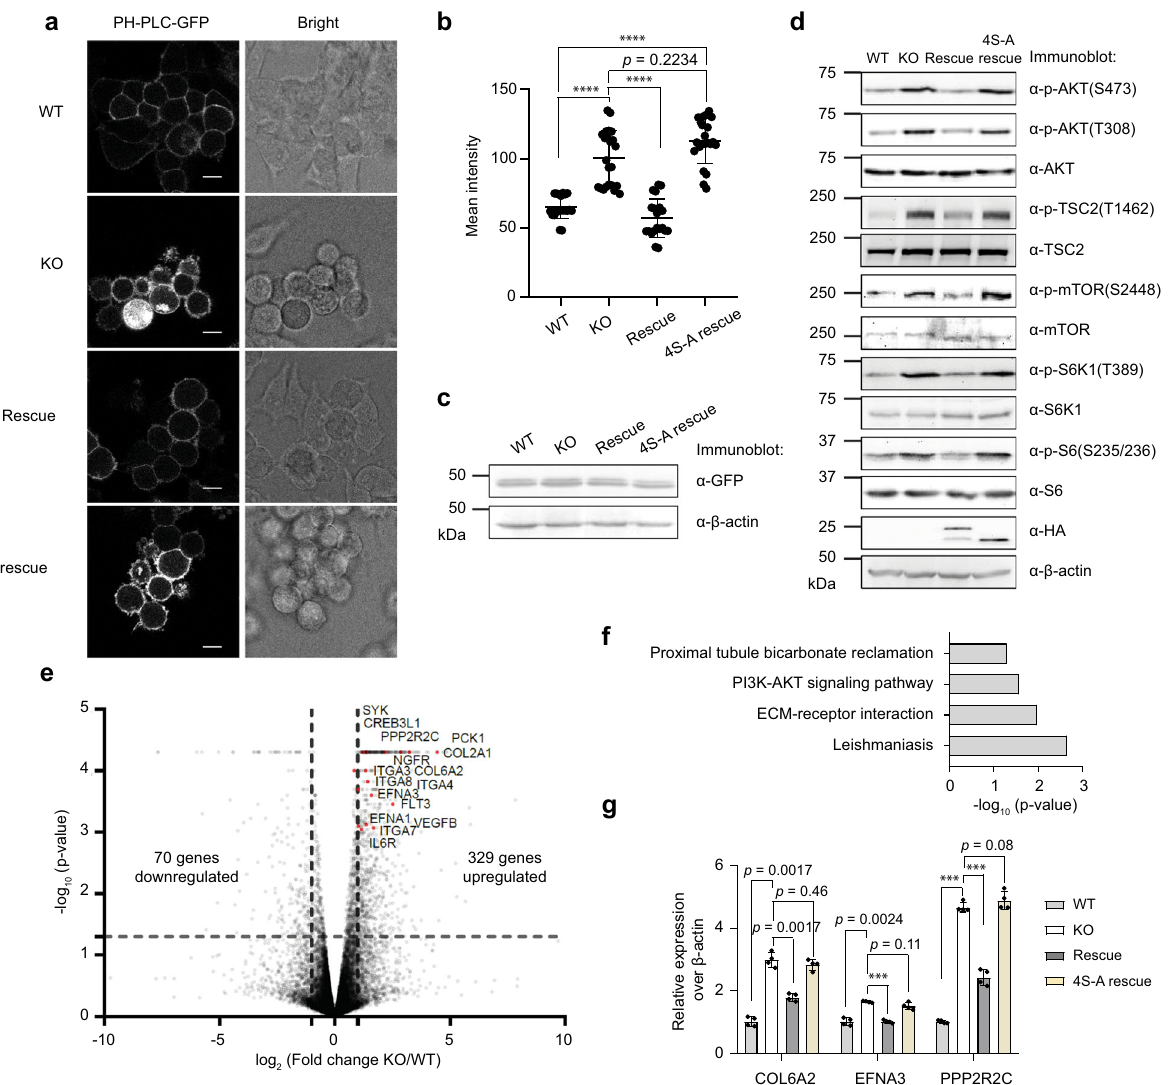
Fig. 5 Phosphorylated alt-RPL36 regulates the PI3K – AKT-mTOR signaling pathway. a Confocal live-cell imaging of wild-type (WT), alt-RPL36 knockout (KO), rescue with wild-type alt-RPL36 (Rescue) or rescue with nonphosphorylatable 4S-A mutant alt-RPL36 (4S-A rescue) HEK 293T cells stably expressing PH-PLC-GFP. Scale bar, 10 µ m. Data are representative of three biological replicates. b Quantitation of the PH-PLC-GFP signals in the four cell lines described above. At least 20 fi elds of view were analyzed, totaling >400 cells for each measurement. Data represent mean values ± s.e.m., and signi fi cance was evaluated with two-tailed t -test. **** p < 0.0001. Source data are provided as a Source data fi le. c Western blot of the four cell lines with antibodies indicated on the right for comparison of PH-PLC-GFP expression. Data are representative of three biological replicates. d Western blot analysis of the wild-type (WT), alt-RPL36 knockout (KO), rescue with wild-type alt-RPL36-FLAG-HA (Rescue) or rescue with 4S-A mutated alt-RPL36-FLAG-HA (4S-A rescue) HEK 293T cells with antibodies indicated on the right. Data are representative of three biological replicates. e Volcano plot of mRNA-seq from wild-type (WT) and alt-RPL36 knockout (KO) HEK 293T cells. Upregulated transcriptional targets of the PI3K – AKT-mTOR signaling pathway identi fi ed via KEGG analysis are indicated in red and gene names are labeled. Signi fi cance was evaluated with Cuffdiff (two-tailed t -test). Source data are provided as a Source data fi le. f KEGG analysis of genes upregulated upon alt-RPL36 knockout; enriched biological pathways are plotted by signi fi cance (Fisher ’ s one-tailed test). g Quantitative RT-PCR results of PI3K-Akt pathway target transcripts in wild-type (WT), alt-RPL36 knockout (KO), rescue with wild-type alt-RPL36-FLAG-HA (Rescue) or rescue with 4S-A mutated alt-RPL36-FLAG-HA (4S-A rescue) HEK 293T cells. Data represent mean values ± standard error of the mean (s.e.m.) of four biological replicates. Signi fi cance was evaluated with two-tailed t -test. *** p < 0.001. Source data are provided as a Source data fi